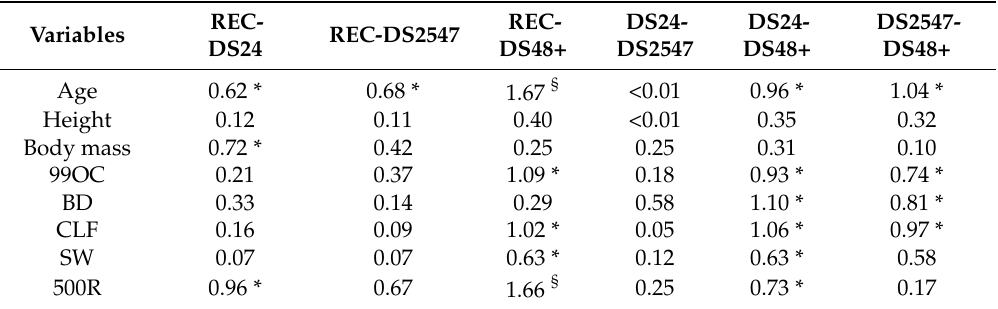
Large effect for the pairwise